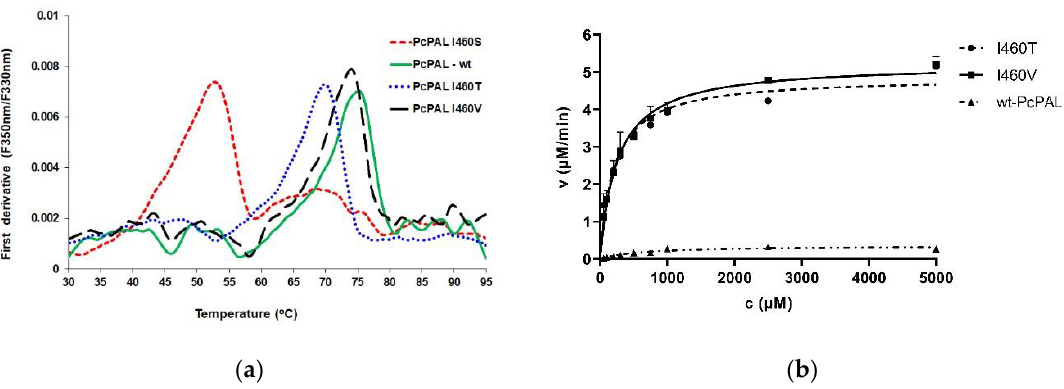
Figure 5. ( a ) The thermal unfolding temperature (T m ) of I460S Pc PAL and I460T Pc PAL, determined by nanoDSF (Prometheus NT.48). Fluorescence intensity ratios F350/F330 and their first derivative are represented as a function of the applied linear thermal ramp ( b ) Michaelis–Menten curves obtained by initial reaction velocity measurements using p -MeO-Phe as substrate at different concentration and purified Pc PAL variants as catalysts.